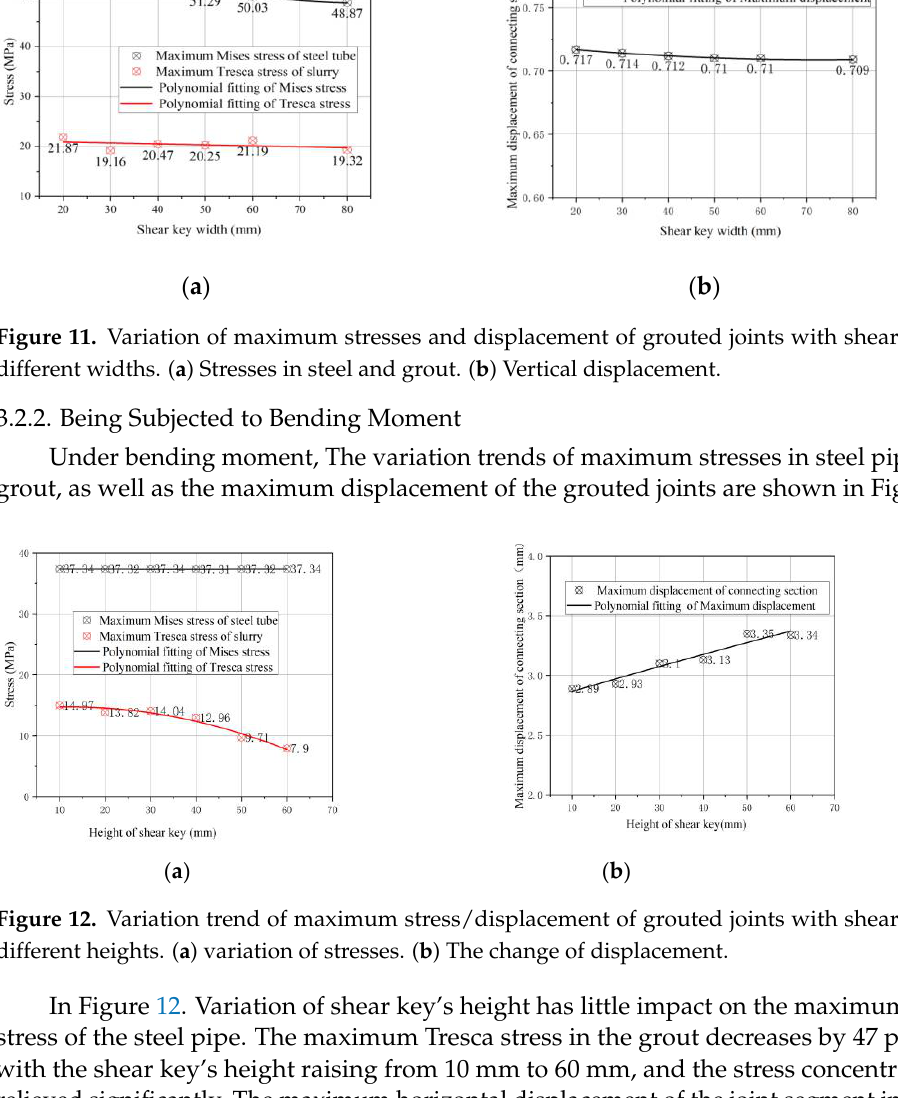
Figure 12. Variation trend of maximum stress/displacement of grouted joints with shear keys in different heights. ( a ) variation of stresses. ( b ) The change of displacement.